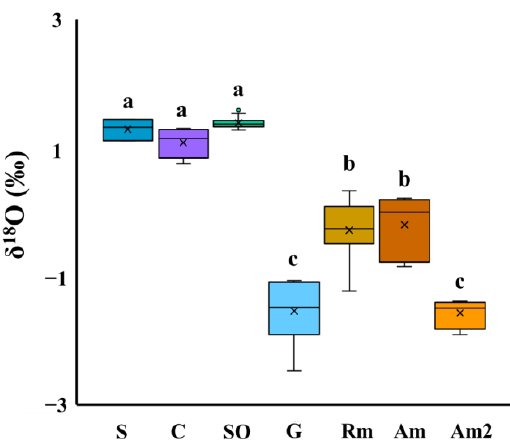
Figure 2. Relationship between δ 2 H and δ 18 O of the environmental water samples and the plant body water samples. The strait and dotted lines show the regression lines for the former samples (Y = 5.48 × X + 1.98, R 2 = 0.96, p < 0.01) and the latter samples (Y = 5.43 × X − 0.12, R 2 = 0.73, p < 0.01), respectively. Rainwater samples were collected in Djibouti City, and the other environmental water samples were collected on Moucha Is., Djibouti.